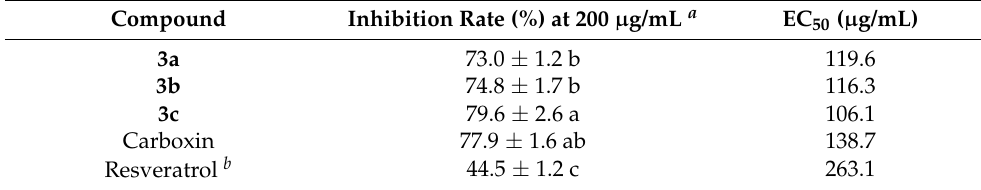
Table 1. In vitro antifungal activities of the target compounds against B. cinerea .